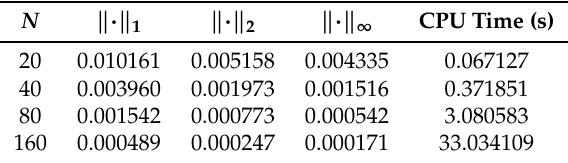
Table 1. Error table using FEM for the approximate solution p ( v , t ) graphically represented in Figure 1, at a final time t = 1.5 with the finest grid being N ∗ = 320.